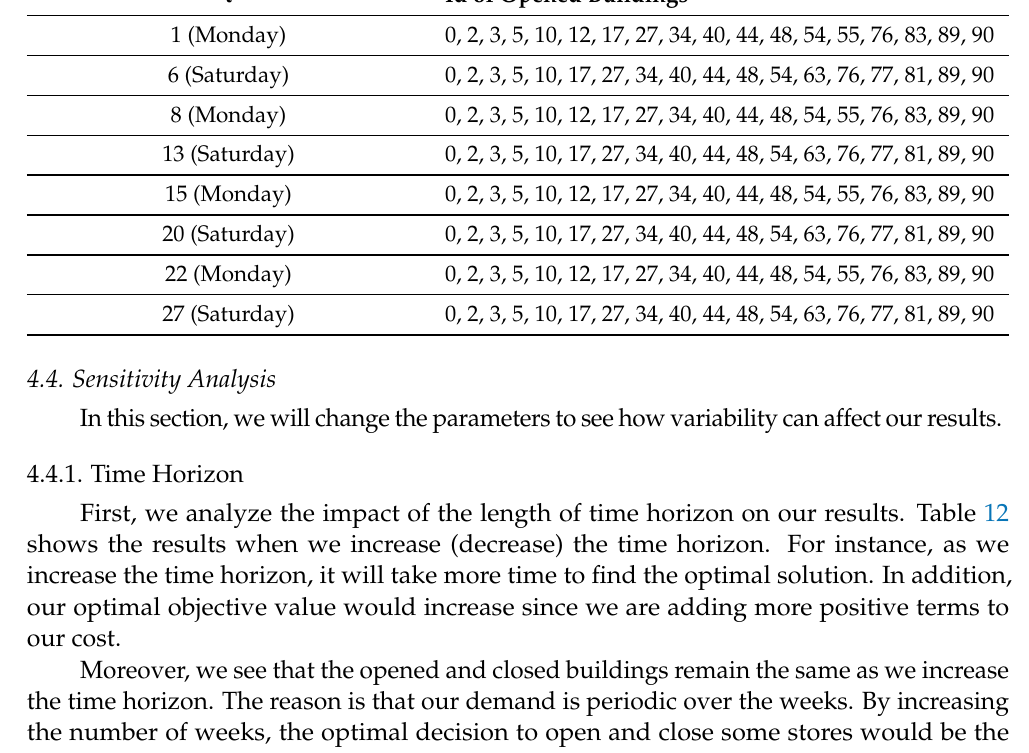
Table 11. Results—Optimal Objective Value = 43175.7, CPU Time = 12.99 s. t Id of Opened